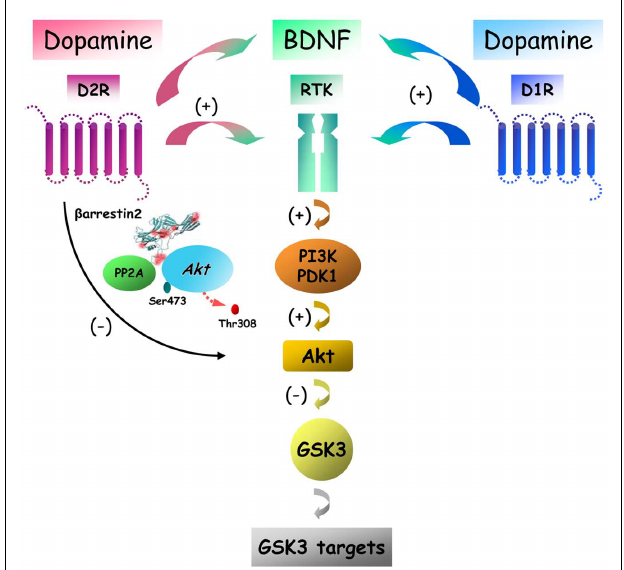
FIGURE 3 | Putative signaling pathways downstream of dopamine receptors with different potential outcomes onAkt/GSK3 signaling . Dopamine receptors can regulate Akt and GSK3 signaling by acting through at least two signaling mechanisms that have an opposite effect on the activity of these two kinases. Activation of D2R leads to a regulated deactivation of Akt by PP2A that is mediated by beta-arrestin 2. In contrast activation of either D1R or D2R can also activate Akt via receptor tyrosine kinase (RTK) transactivation leading to enhancement of Pi3K signaling.